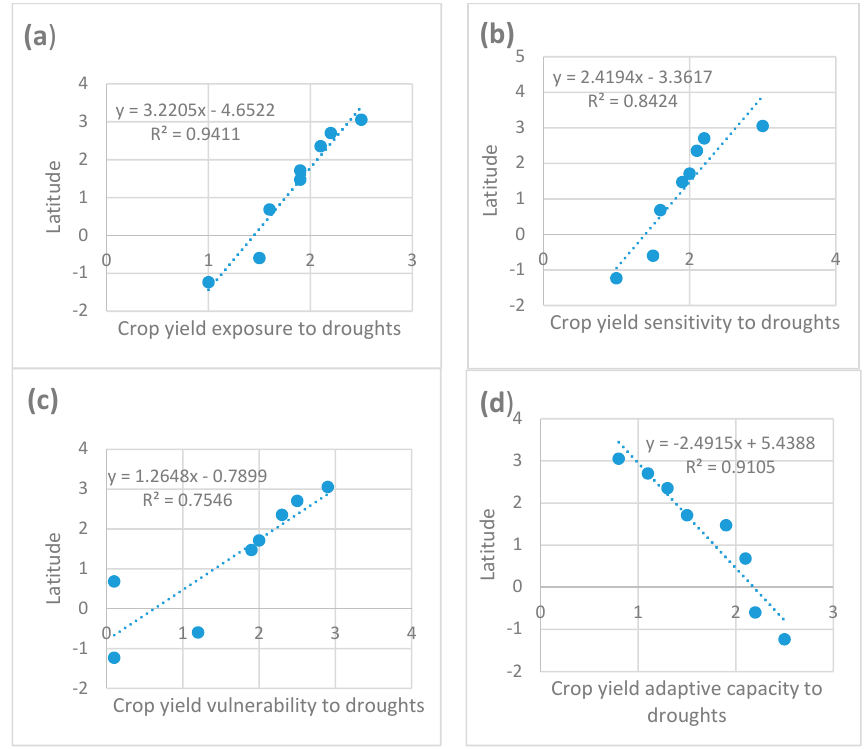
Figure 5. Relationship between latitude and ( a ) crop yield exposure to droughts, ( b ) crop yield sensitivity to droughts, ( c ) crop yield vulnerability to droughts and ( d ) crop yield adaptive capacity to droughts.